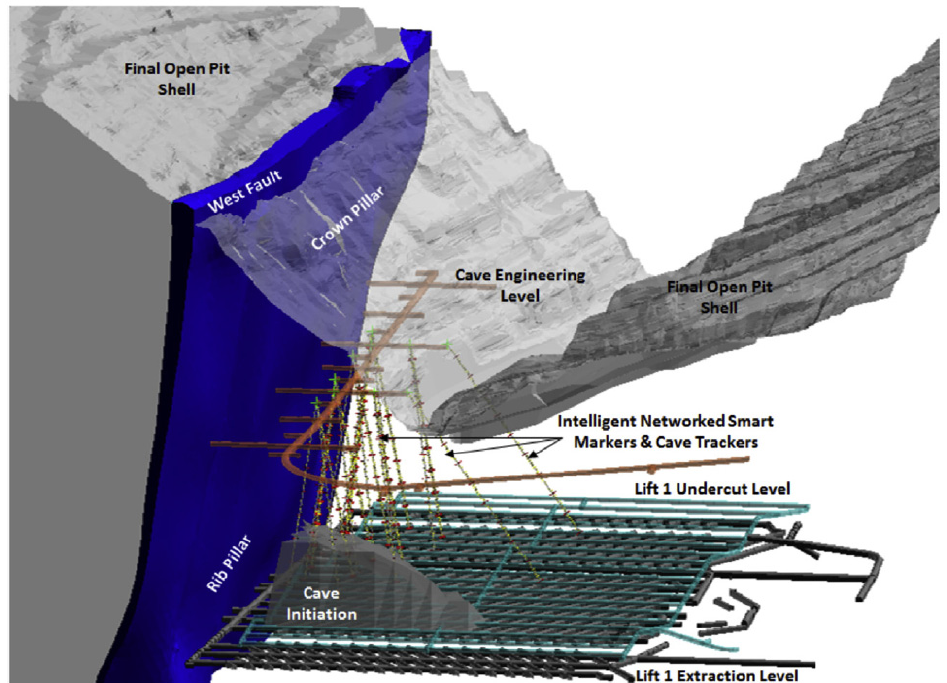
Figure 3. Chuquicamata transition project and west fault [44], isometric view.